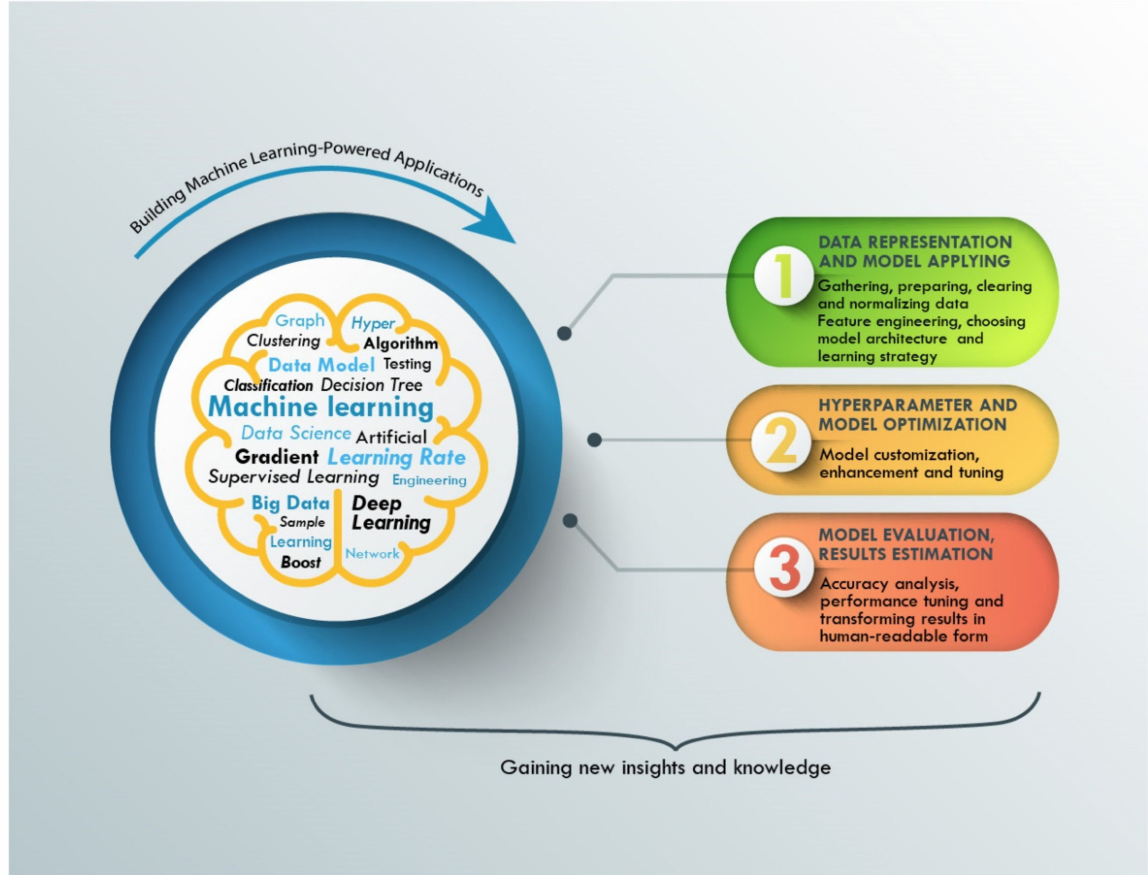
Figure 2. Machine learning powered problem-solving